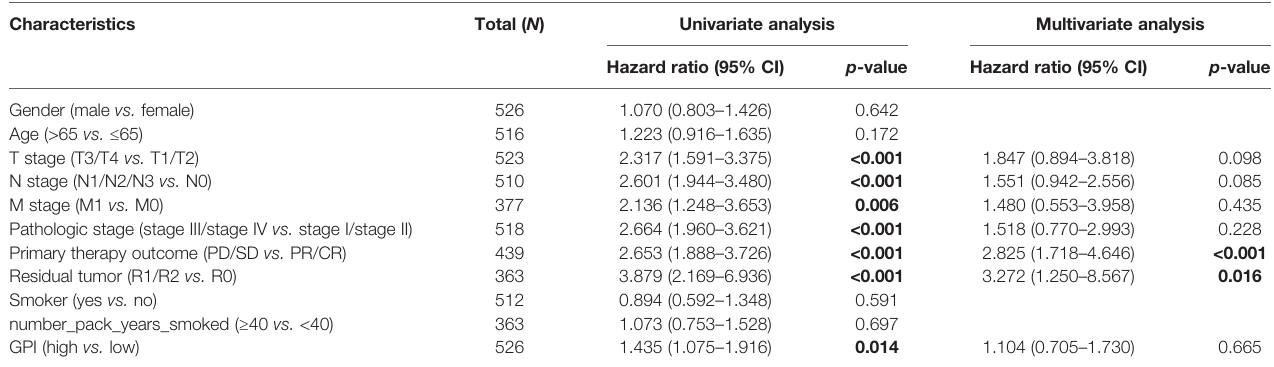
TABLE 2 | Univariate and multivariate Cox regression analyses of the clinical characteristics associated with overall survival in lung adenocarcinoma (LUAD) in The Cancer Genome Atlas (TCGA). Characteristics